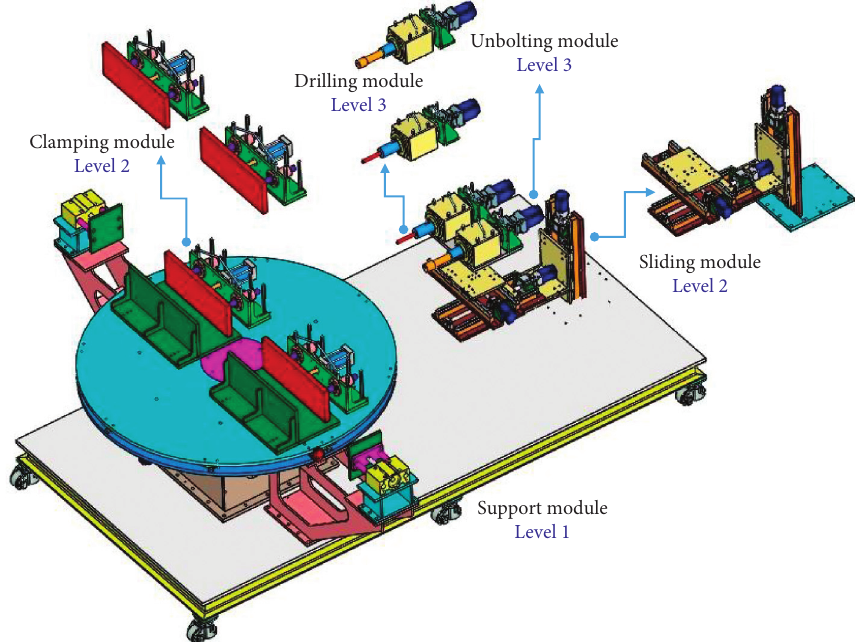
Figure 8: Disassembler modules configuration